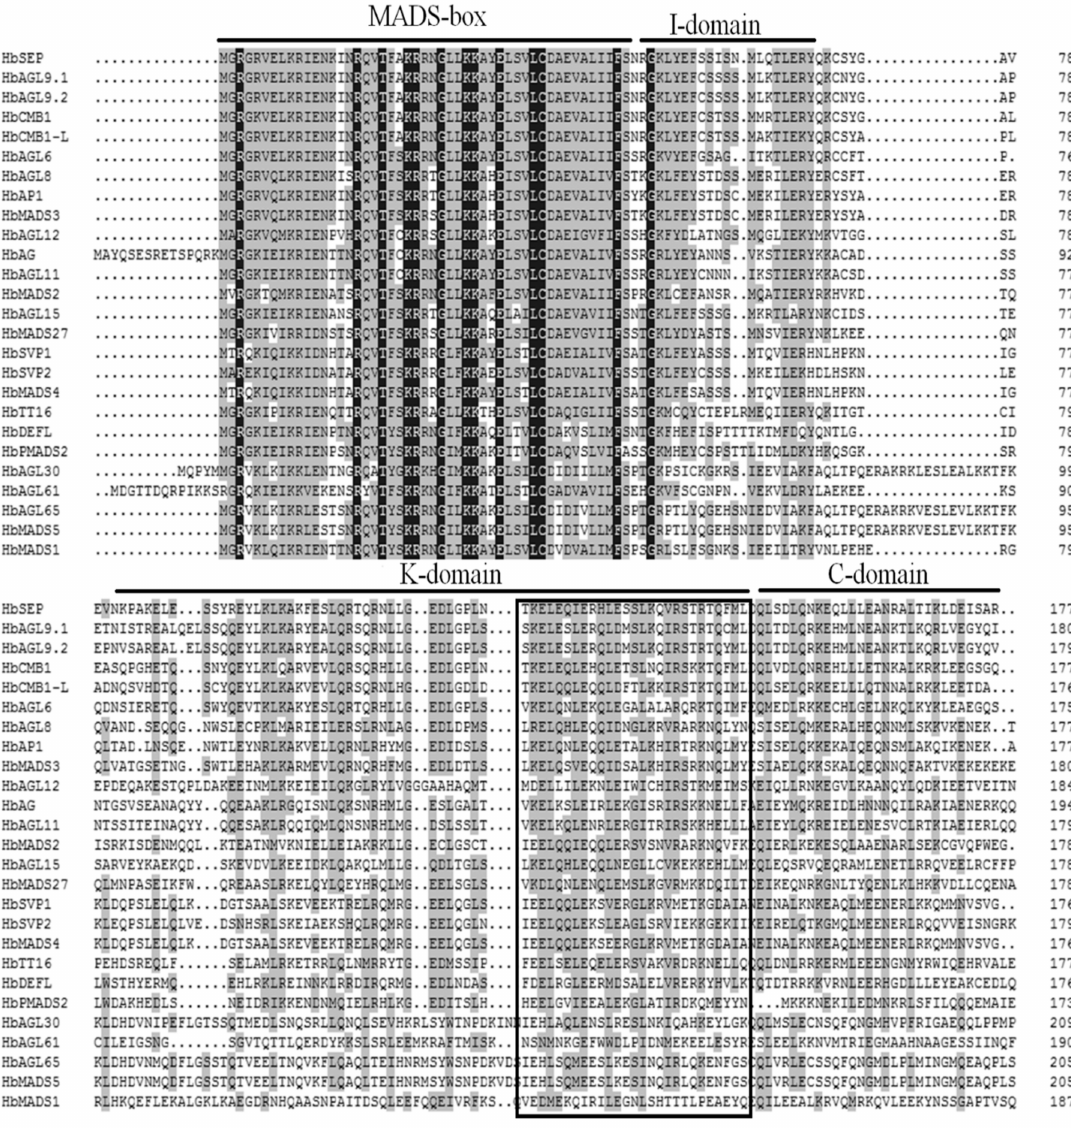
Figure 1. Phylogenetic analysis of HbMADS-box genes related proteins. MADS-box, I domain, K domain, and C domain are marked, respectively; coiled-coil domain is